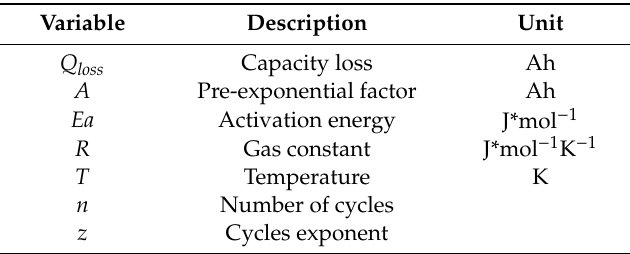
Table 1. Battery ageing